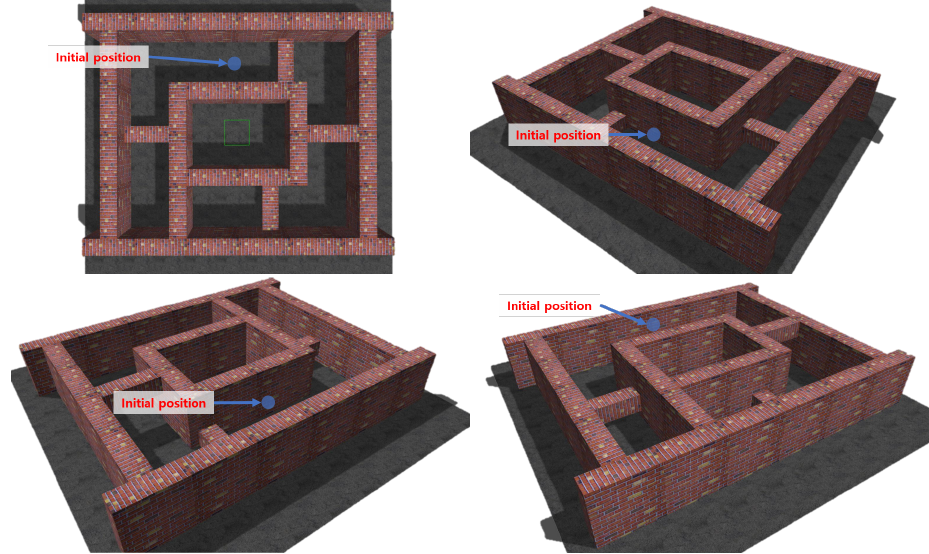
Figure 10. Simulation environment for the integrated obstacle avoidance strategy.